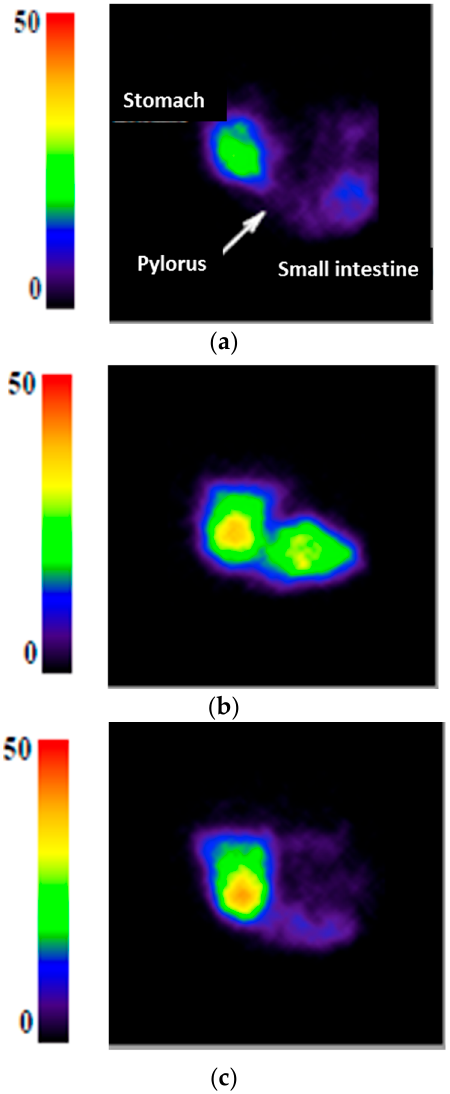
Figure 2. Images of the gastrointestinal region taken 60 min after meal ingestion for the control yogurt ( a ) the low viscosity yogurt; ( b ) and the high viscosity yogurt; and ( c ) The output of the radio-isotopic counter was expressed through a scale ranging from 0 to 50.